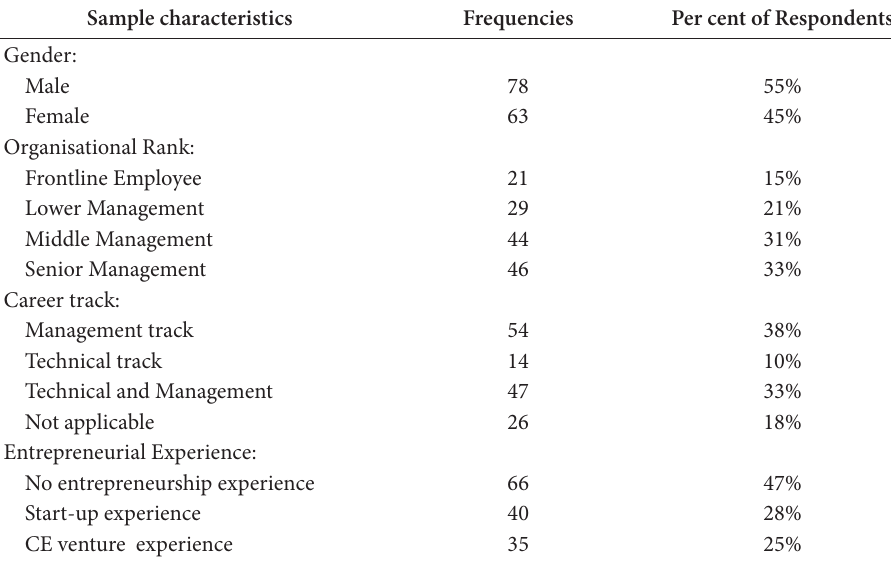
Table 1. Respondent characteristics Sample